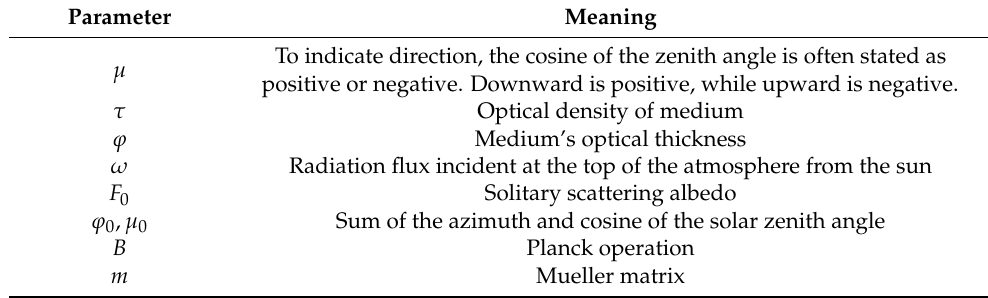
Table 1. The parameters and definitions of the vector radiative transfer equation. Parameter Meaning To indicate direction, the cosine of the zenith angle is often stated as µ positive or negative. Downward is positive, while upward is negative. τ Optical density of medium ϕ Medium’s optical thickness ω Radiation flux incident at the top of the atmosphere from the sun F 0 Solitary scattering albedo ϕ 0 , µ 0 Sum of the azimuth and cosine of the solar zenith angle B Planck operation m Mueller matrix 1 (cid:82) 2 π (cid:82) m ( τ , µ , φ ; µ (cid:48) , φ (cid:48) ) I ( τ , µ (cid:48) , φ (cid:48) ) d µ (cid:48) d φ (cid:48) represents the intensity In Formula (13), ω 4 π − 1 0